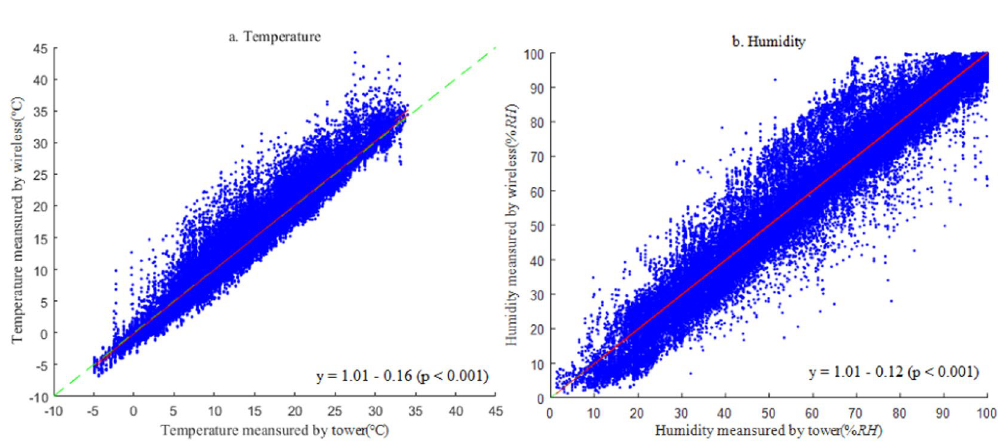
Figure 6. Accuracy evaluation of the calibrated temperature ( a ) and humidity ( b ) observed by the wireless